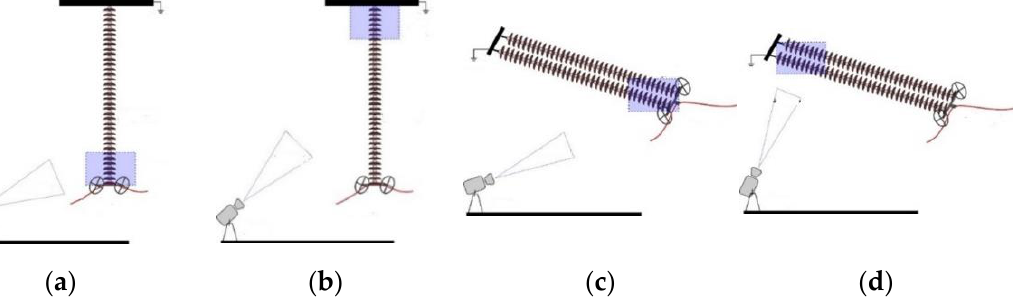
Figure 1. The recording technique: ( a ) initial position for suspension string; ( b ) final position for suspension string; ( c ) initial position for tension string; ( d ) final position for tension string.